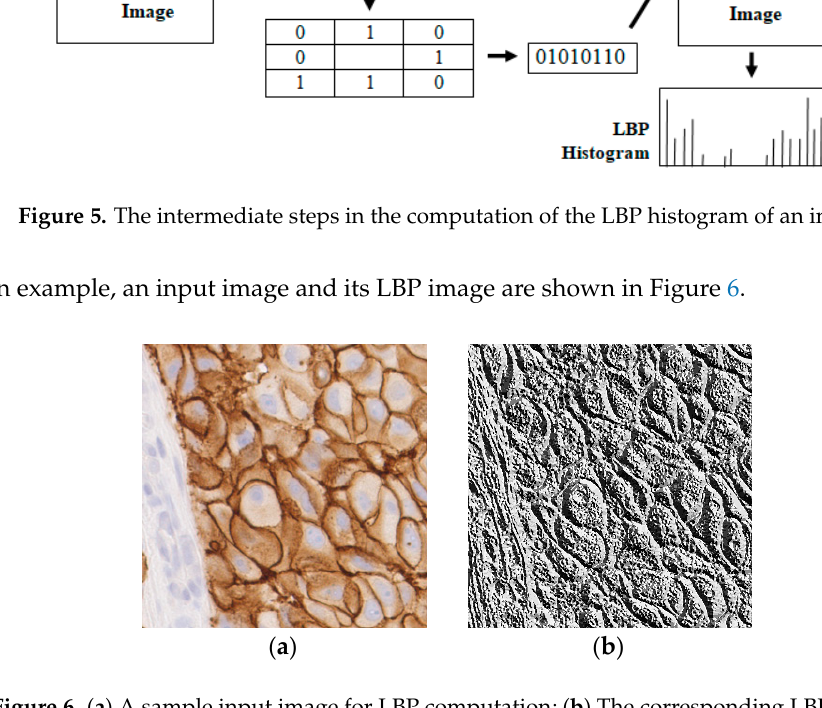
Table 3. Nine different classes of uniform Local Binary Patterns.